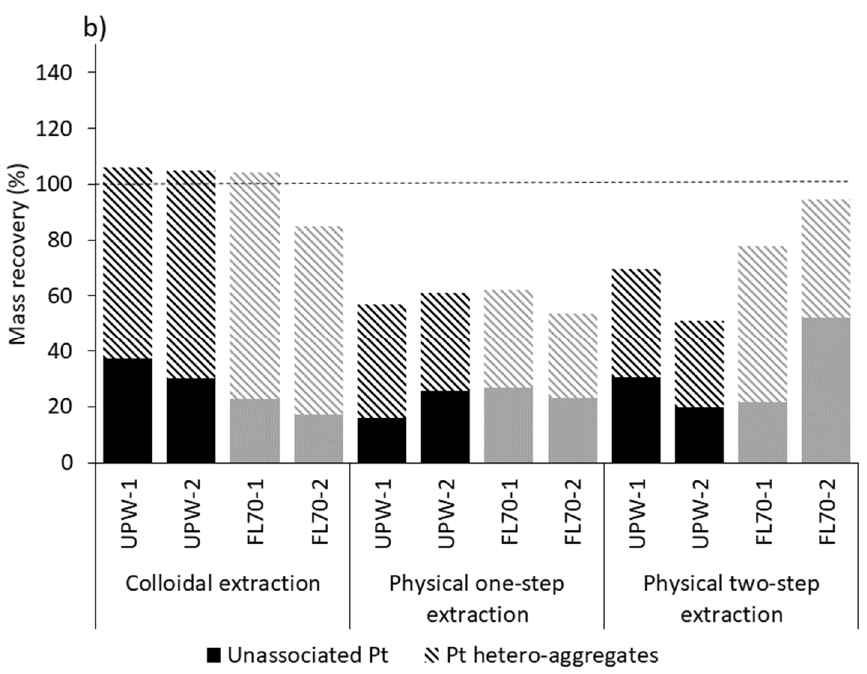
Figure 5. ( a ) Particle number recoveries (NP % ) and ( b ) particle mass recoveries (M % ) of unassociated Pt NPs and Pt NPs aggregated with other particles calculated in the Pt-spiked sediment samples for each extraction procedure using UPW or FL70 as a stabilizer.